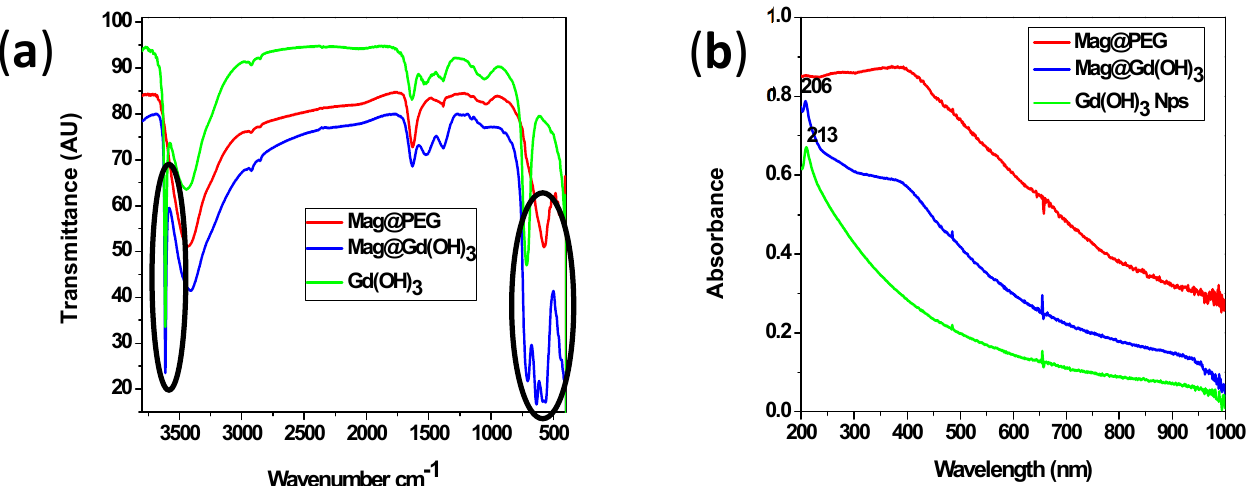
Figure 2. ( a ) FTIR spectra of the three nanosystems. The regions that reveal the presence of both Gd(OH) 3 and maghemite are marked. ( b ) UV–Vis spectra of the nanoparticles.